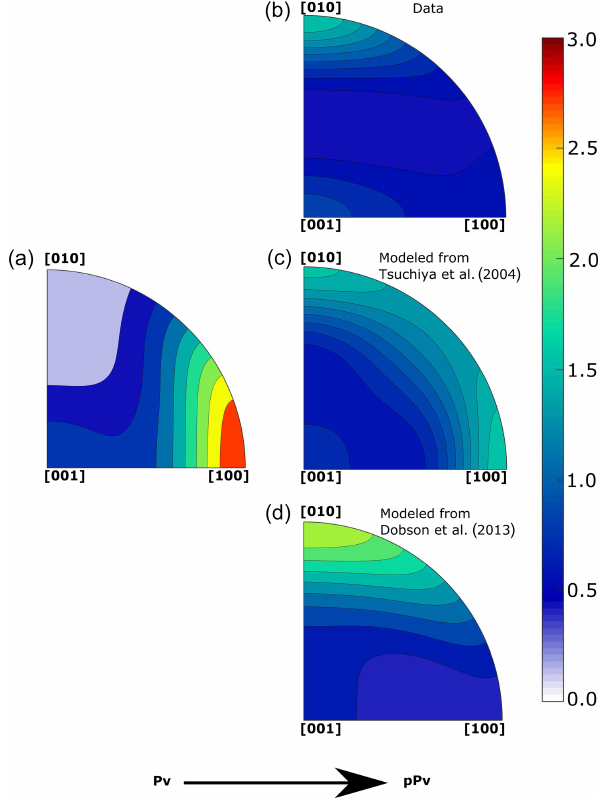
Figure 7. (a) Perovskite texture at 20.1GPa immediately before transformation to post-perovskite. (b) Post-perovskite texture at 26.1GPa after transformation from experimental measurements. (c) Modeled transformation texture of post-perovskite using orientation relationships from Tsuchiya et al. (2004). (d) Modeled transforma- tion texture of post-perovskite using orientation relationships from Dobson et al.